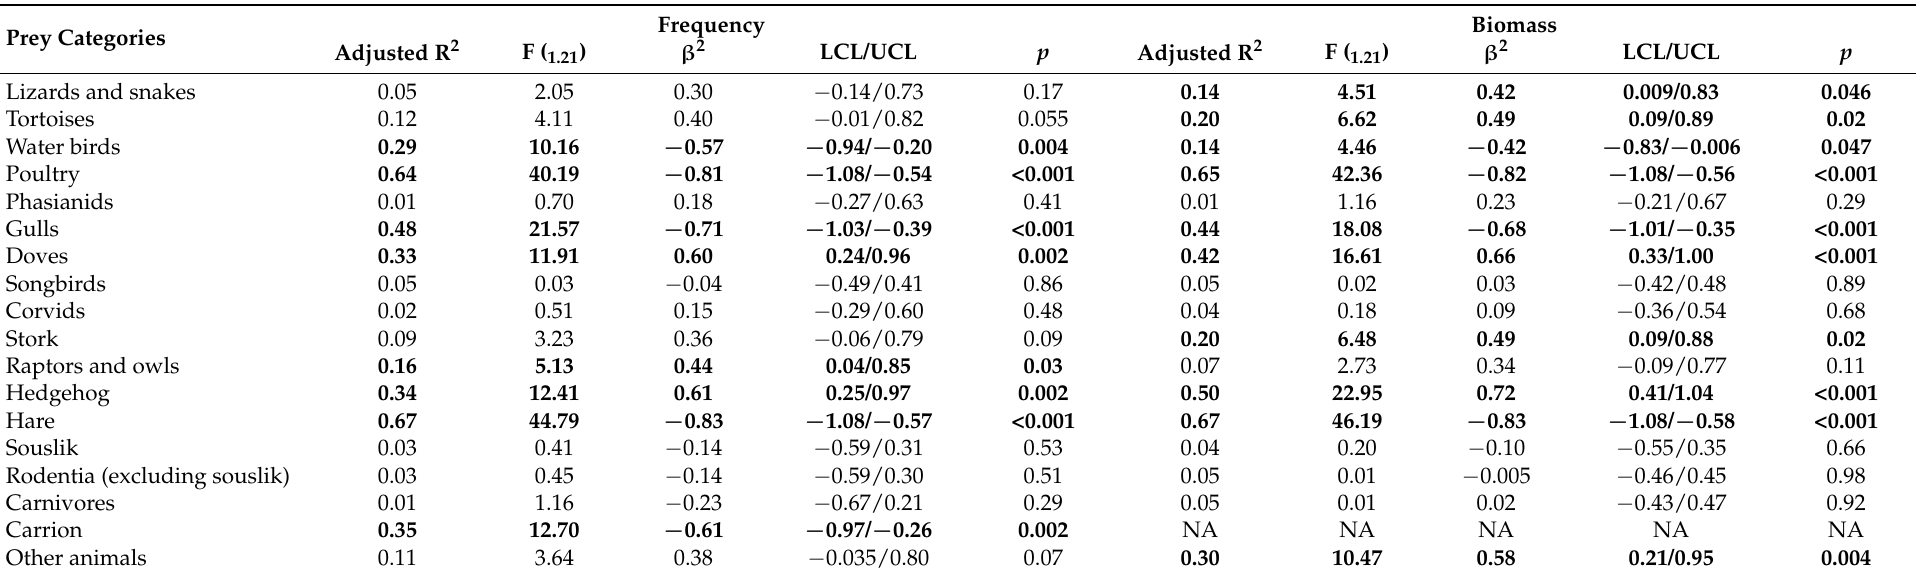
Table 2. Results of the over-parameterized linear model (GLM) carried out to analyze the trend of the different prey categories (frequency and biomass contribution) of the eastern imperial eagle between 1999 and 2021. We used adjusted R 2 value as a correction factor, explanatory parameter estimates ( β 2 ) with lower (95%) and upper CL (95%), and a probability value ( p ) of the explanatory factors. Significant values are given in